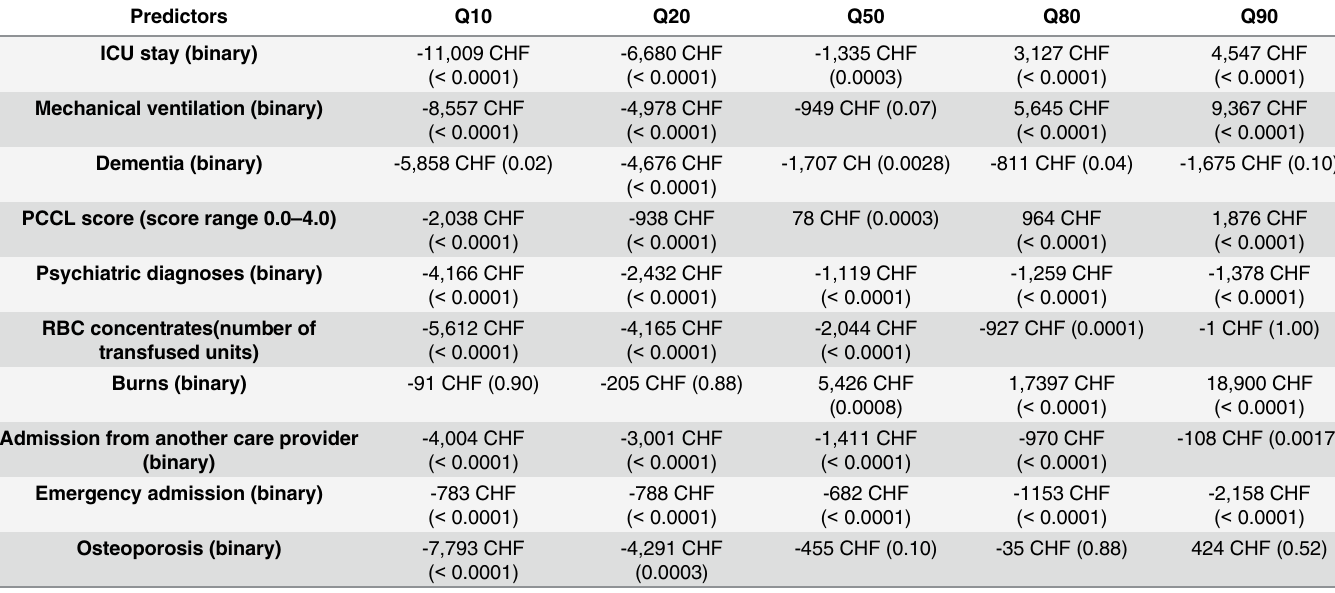
Table 6. Quantile regression of ten selected predictors for earnings (n = 20,000, training